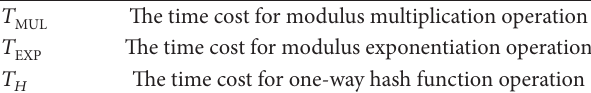
Table 2: Definition of the notation. 𝑇 The time cost for modulus multiplication operation MUL 𝑇 The time cost for modulus exponentiation operation EXP 𝑇